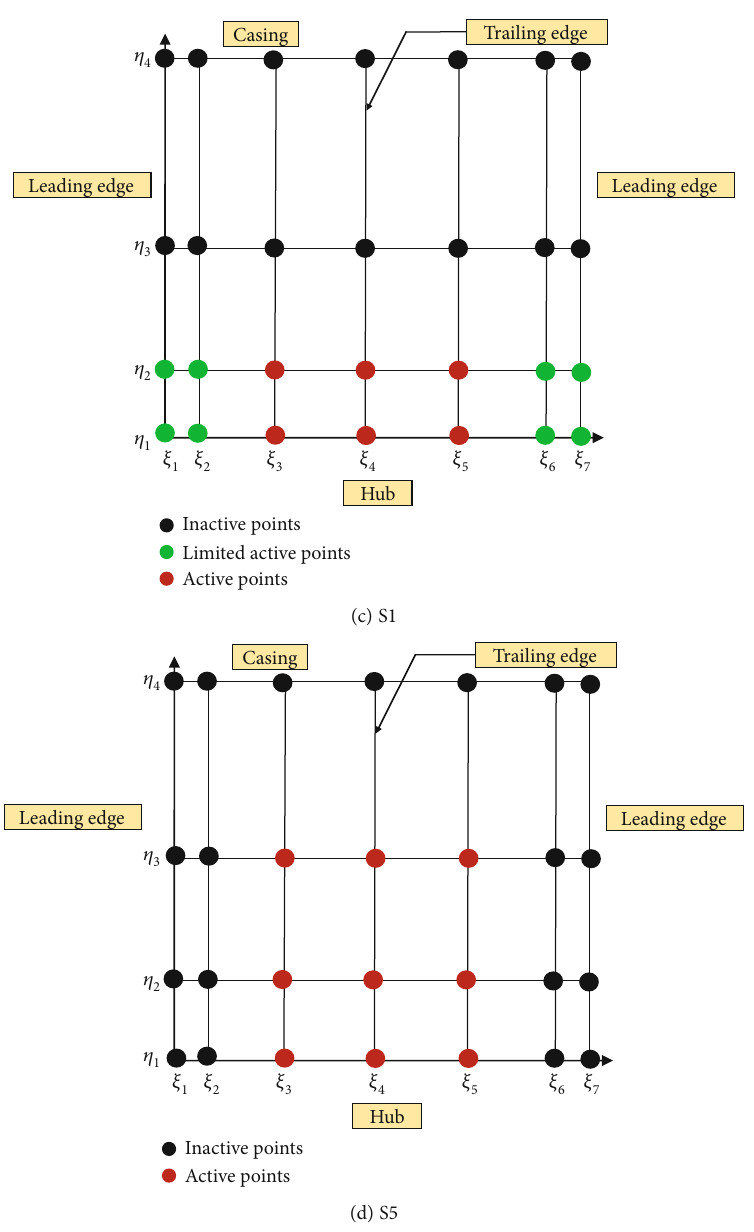
Figure 12: Distribution diagram of the control points of each selected blade in the second phase. Table 4: Time consumption comparison of di ff erent optimization